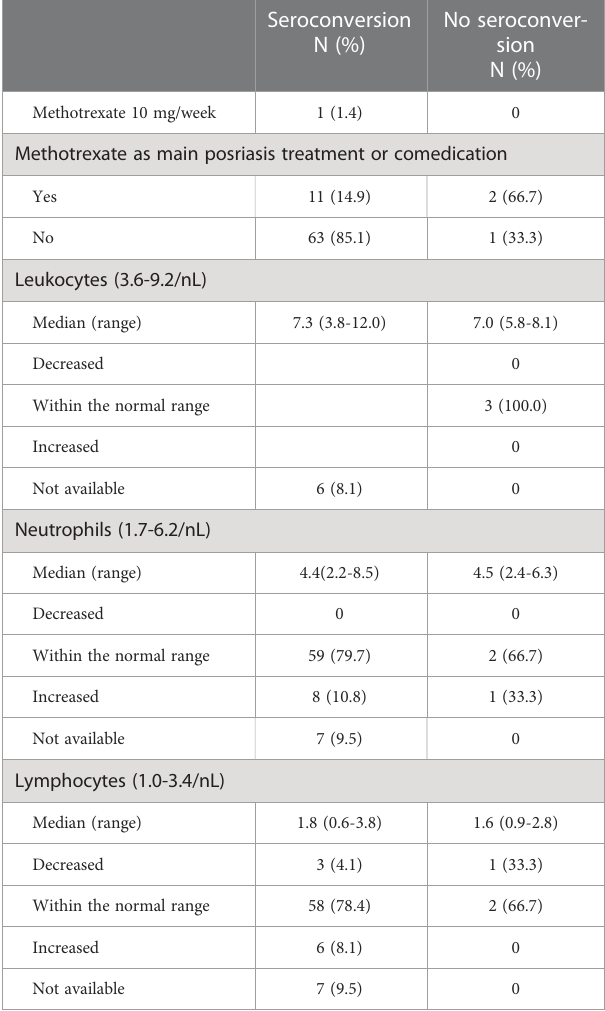
TABLE 3 Characteristics of patients with and without anti-SARS-CoV-2- S IgG